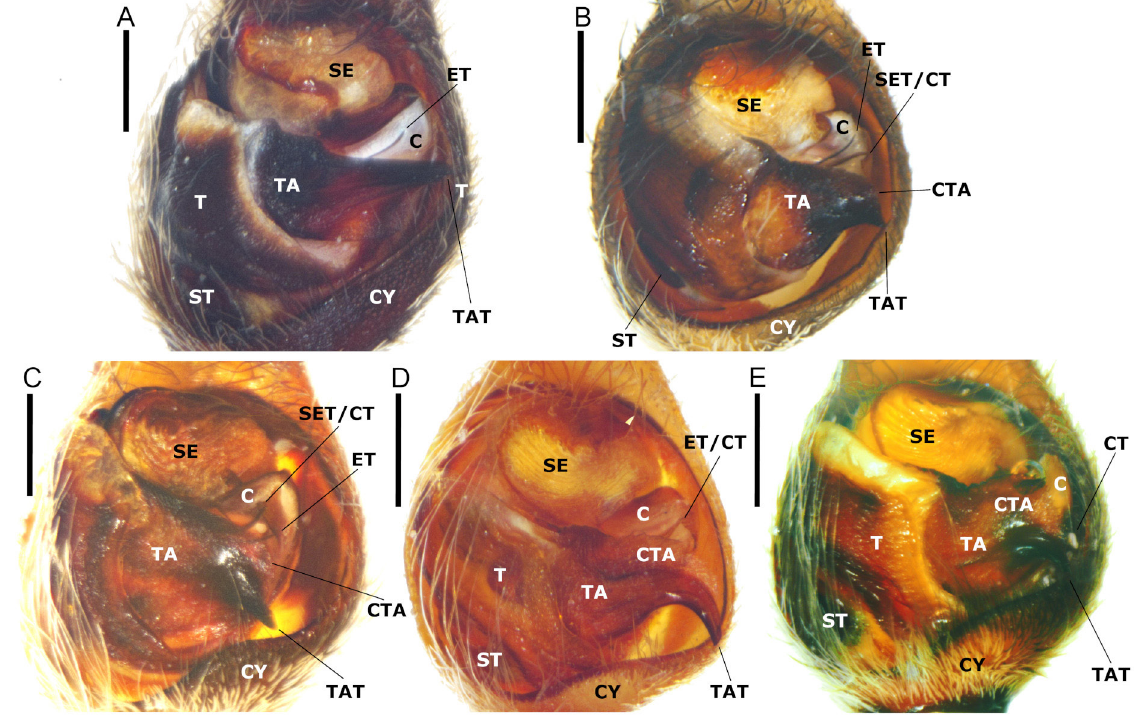
Fig. 2. ♂♂ Pedipalps, ventral view. A . Geolycosa vultuosa C.L. Koch, 1838 (HUJ INV-AR20960). B . Lycosa gesserit sp. nov., holotype (HUJ INV-AR20631). C . Lycosa hyraculus sp. nov., holotype (HUJ INV-AR20818). D . Lycosa piochardi Simon, 1876 (HUJ INV-AR20948). E . Lycosa praegrandis C.L. Koch, 1836 (Veles, North Macedonia; 1 Jun. 2002; courtesy of Marjan Komnenov). Scale bars = 0.5 mm. Photos by I. Armiach